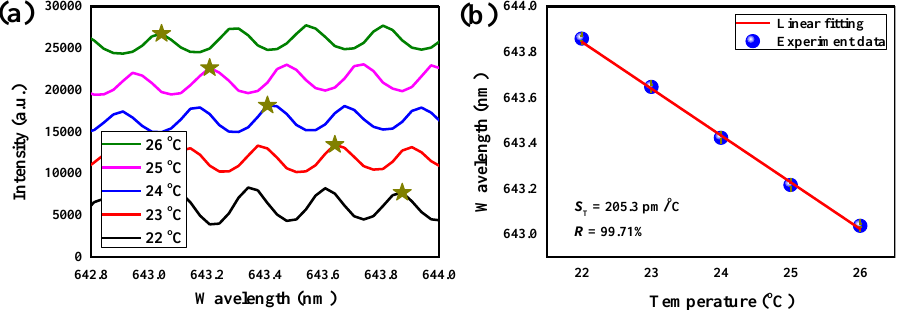
Figure 10. ( a ) The laser spectra of the WGM resonance at the temperature range from 22 to 26 °C. ( b ) The lasing resonance wavelength shifts as a linear function of the temperature.